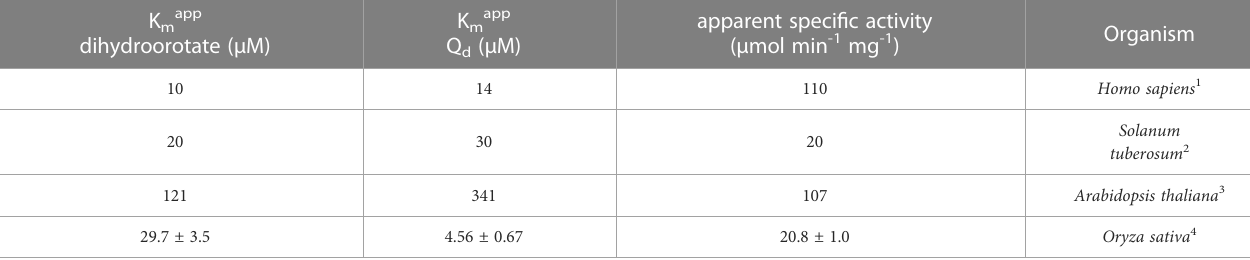
TABLE 2 Apparent kinetic parameters of dihydroorotate dehydrogenases from different organisms. K